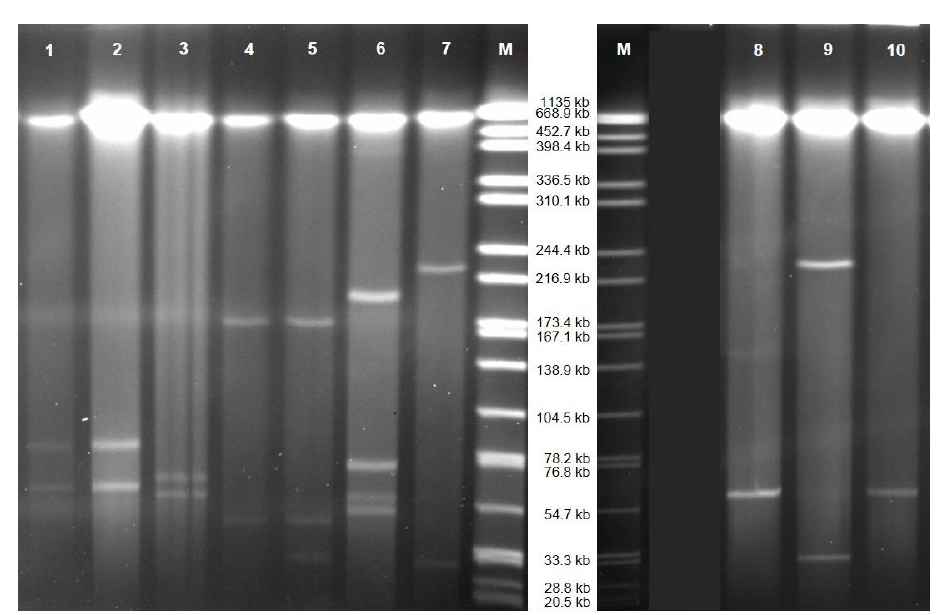
Figure A1. Plasmids of seven OXA-48 producing Klebsiella pneumoniae isolates and two Escherichia coli transconjugants visualized by S1-nuclease restriction and pulsed-field gel electrophoresis. Lane 1, K. pneumoniae -ST101 Kp_Goe_33208; lane 2, K. pneumoniae -ST101 Kp_Goe_71070; lane 3, K. pneumoniae -ST101 Kp_Goe_121641; lane 4, K. pneumoniae -ST11 Kp_Goe_821588; lane 5, K. pneumoniae - ST11 Kp_Goe_822917; lane 6, K. pneumoniae -ST23 Kp_Goe_154414; lane 8, Kp_Goe_121641- E.